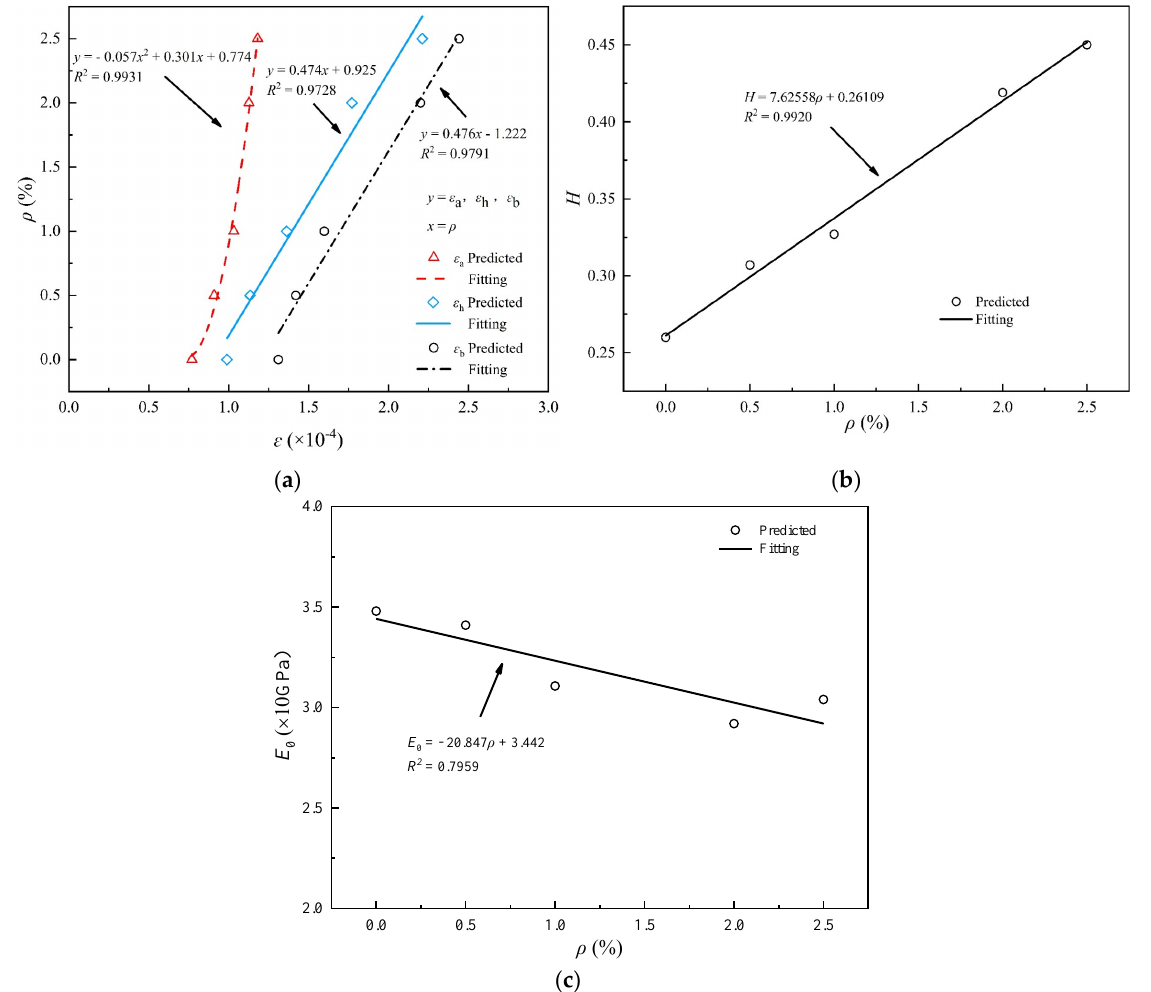
Figure 8. Influence of fiber volume fraction on the characteristic parameters: ( a ) ρ - εa , εh , εb curves; ( b ) H - ρ curve; ( c ) E 0 - ρ curve.